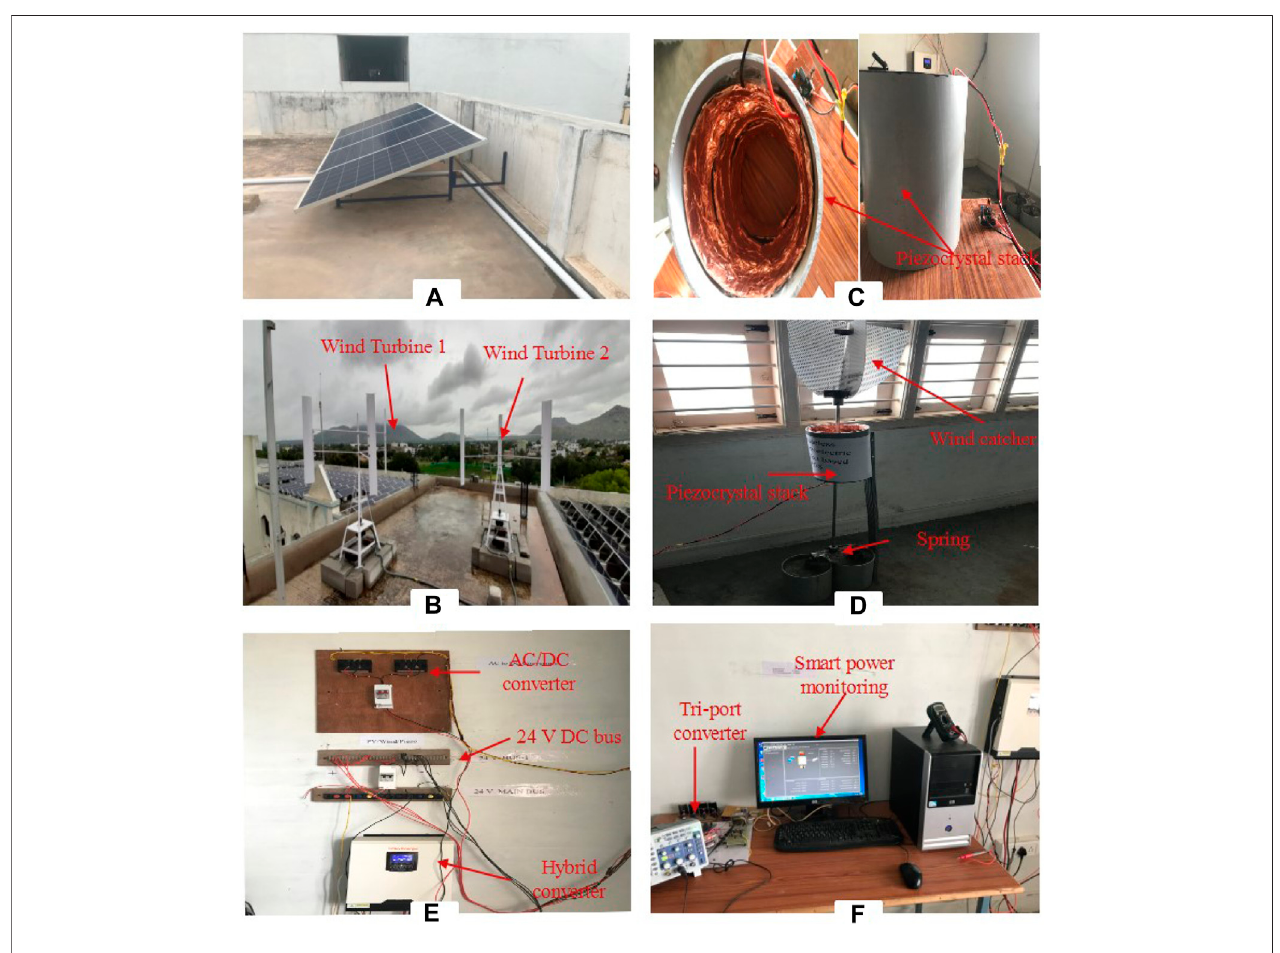
FIGURE 6 | Experimental setup for the